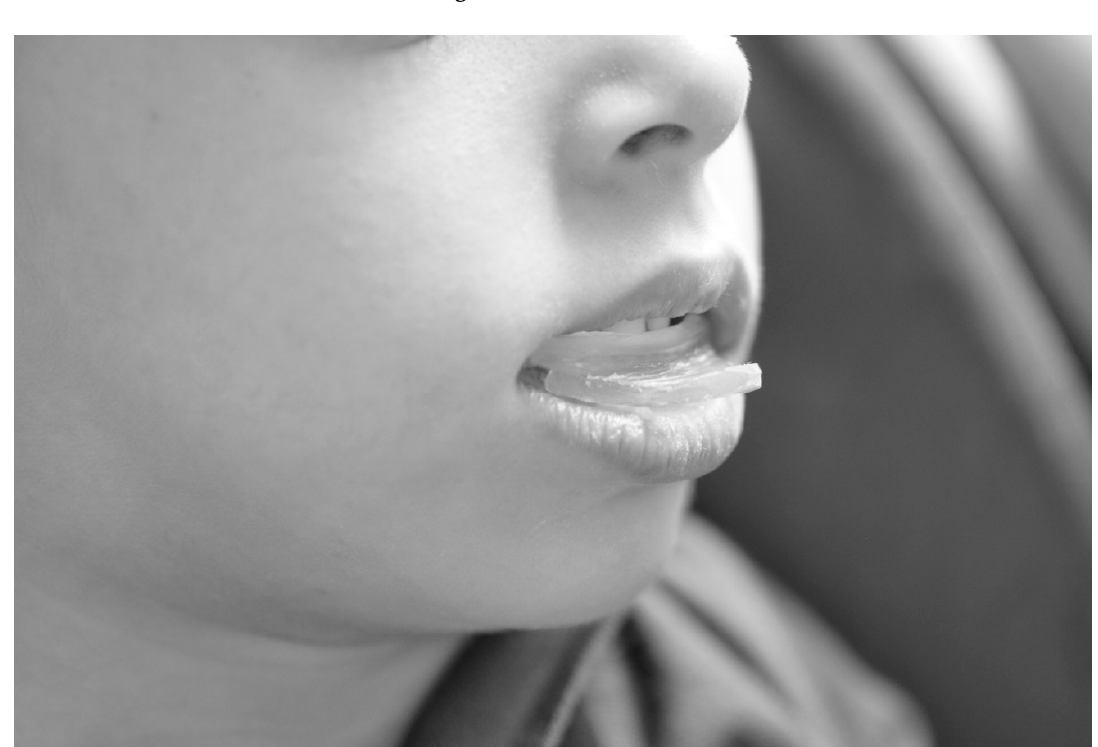
Figure 8. Bite application.